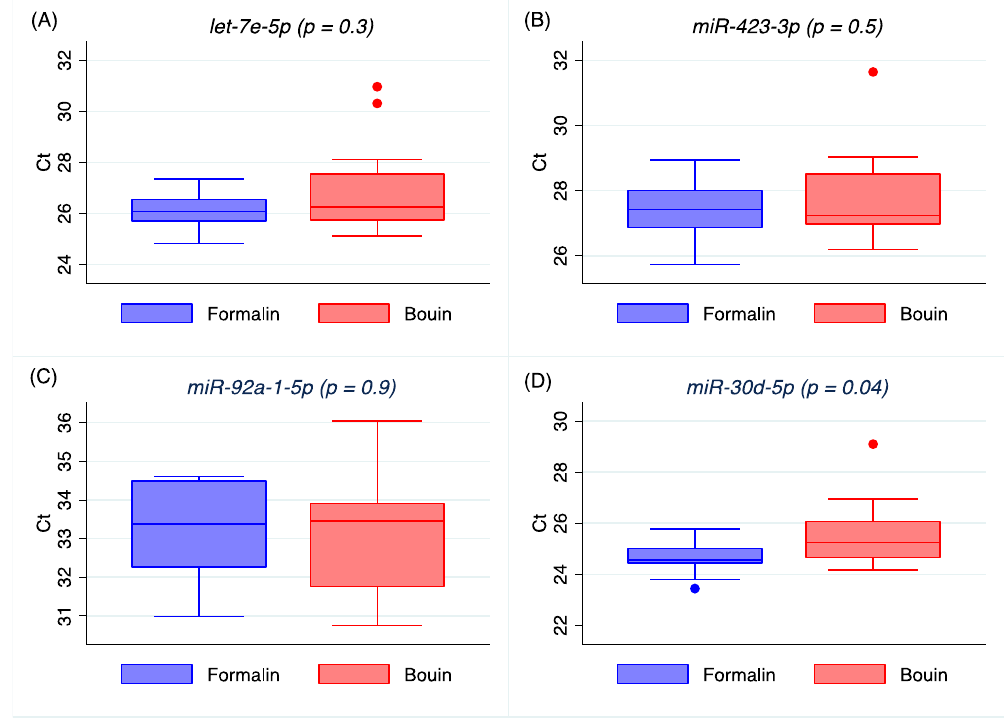
Figure 2. Box plot representing quantitative reverse transcription polymerase chain reaction (RT/qPCR) of let-7e-5p ( A ), miR-423-3p ( B ), miR-92a-1-5p ( C ), and miR-30d-5p ( D ) in matched formalin- and Bouin’s-fixed tissues by real-time PCR. The box represents the first and third quartiles, intersected by the median, and the whiskers are the range. Table 2. Median Ct values of real-time PCR and median copies/µL of ddPCR results with variation coefficient for the analyzed miRNAs.